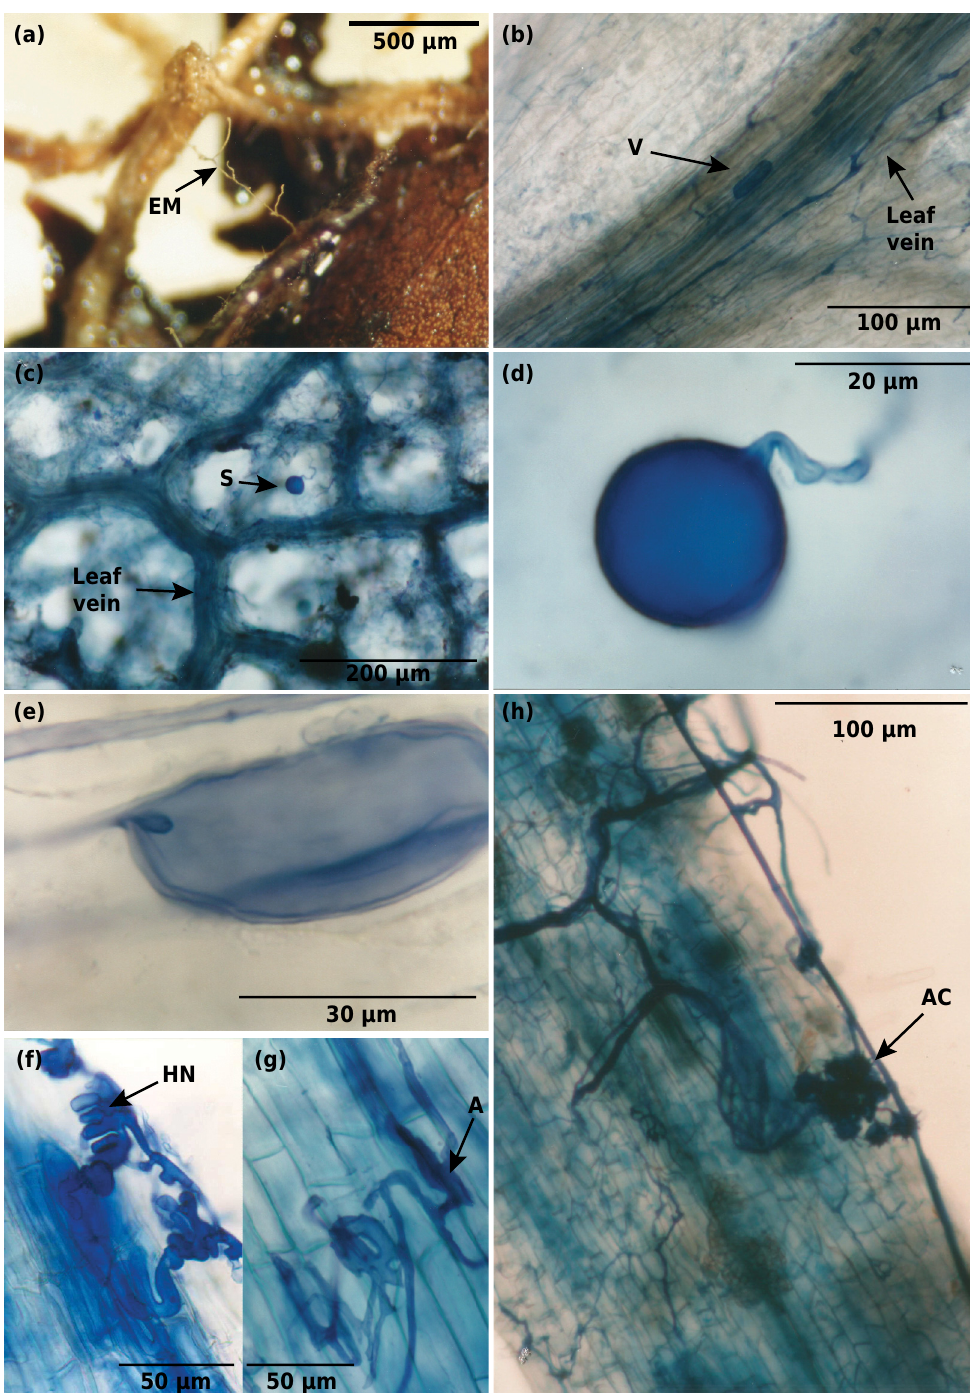
Figure 1. Colonization of leaf litter and roots by AMF. External mycelium (a). Hyphae and a vesicle colonizing a leaf vein in a sample from CH (b). Spore found in leaf tissue from OR (c). Magnified AMF spore found in leaf litter from plot OR (d). Arbuscular mycorrhizal fungal vesicle found in Fraxinus sp. leaf litter from plot CH (e). Arbuscular mycorrhizal fungal hyphal infection networks (f). Hyphae and appressorium formation (g). External mycelium and auxiliary cells typical of some Gigasporaceae fungi in roots from CH (h). EM: external mycelium; V: vesicle; S: spore; HN: hyphal infection networks; A: appressorium; AC: auxiliary